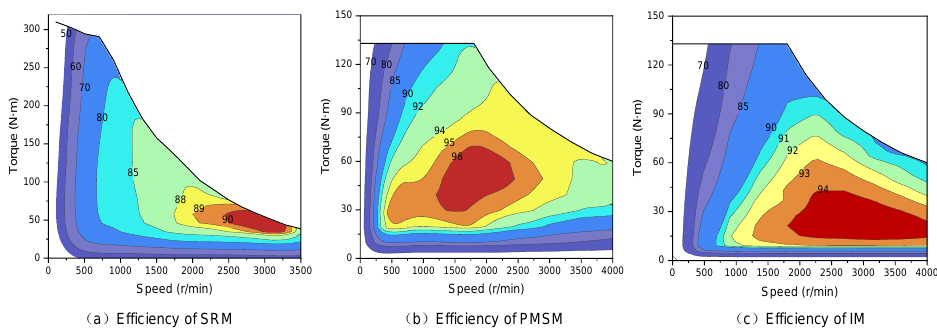
Figure 4. Efficiency map of three hydraulic motors. ( a ) Effiency of SRM. ( b ) Effiency of PMSM. ( c ) Effiency of